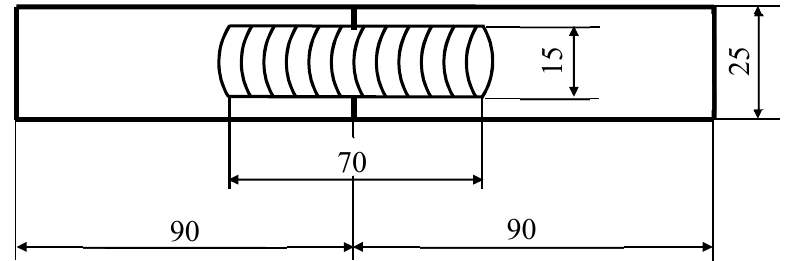
Figure 1. Scheme of test specimen and dimensions in millimeters.